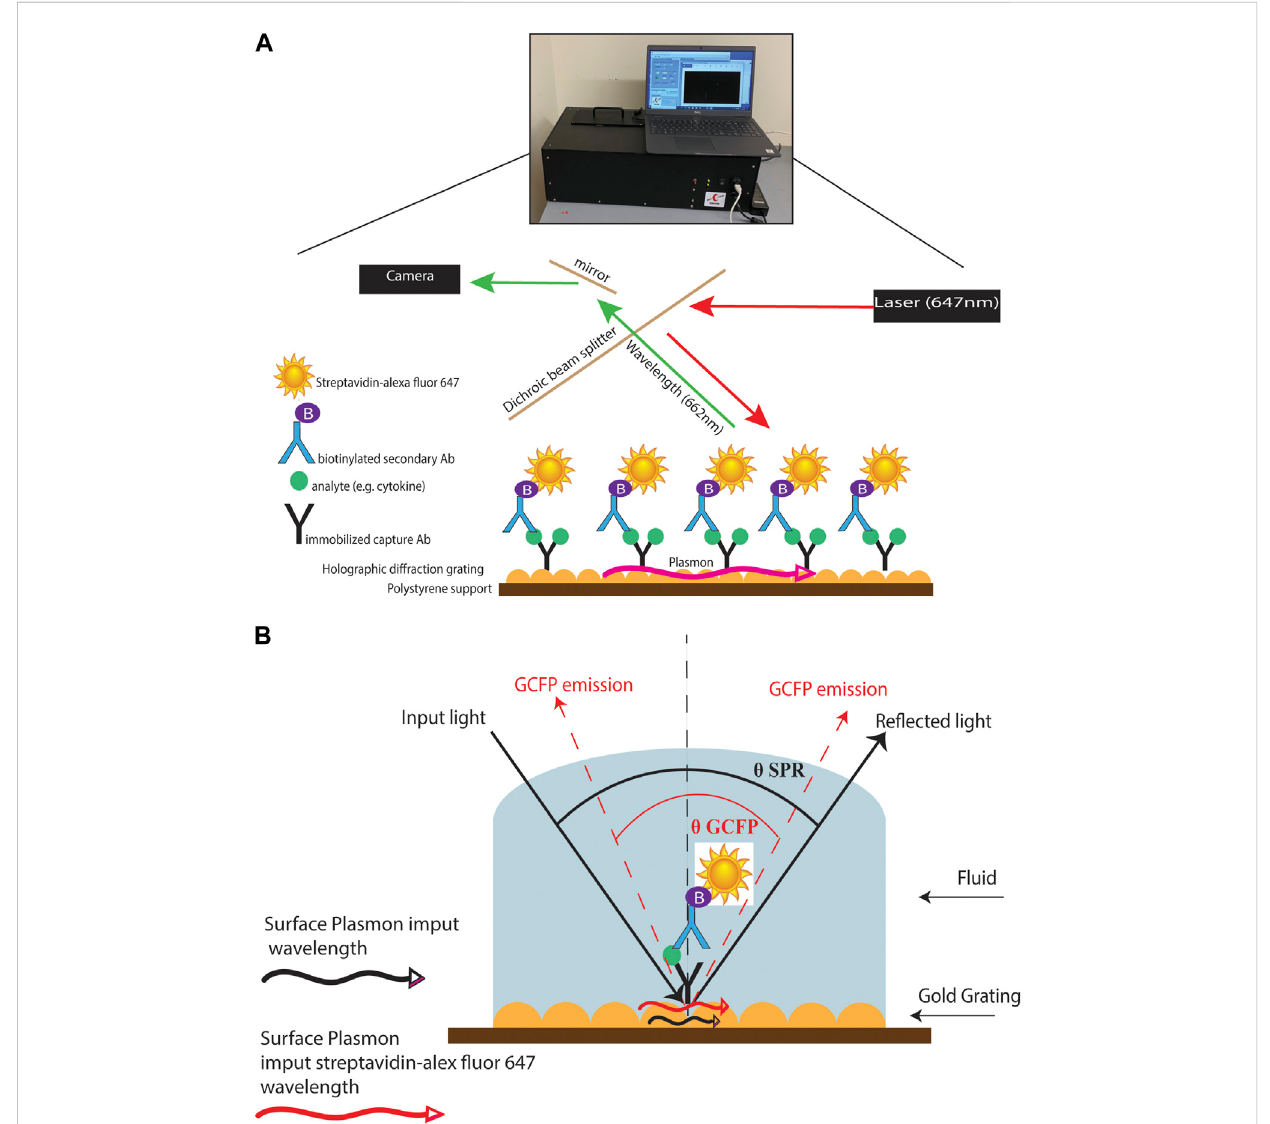
FIGURE 1 GCFP assay and wavelength pathway. ( A) Capture antibodies are immobilized onto a gold-coated nanoscale grating surface chip by pin spotting. Chips were then fi tted with plexiglass windows and gaskets to create a fl ow cell for fl uid to pass over the surface of the printed chip. Fluid containing potential analytes can then be run over the assembled chip, followed by biotinylated secondary antibodies and then streptavidin-Alexa fl uor647, with washesinbetweenstepswithPSB-T. ThechipcanthenbeplacedinaGCFPreaderwhere alaserilluminates thechipandthe fl uorescenceintensity is collected with a camera and each ROI is analyzed using Enhanced Fluorescence Reader software, V2.3. (B) . Under normal SPR optical conditions, the energy of the light excites electron density oscillation (the plasmon) within the metal coating on the sensor chip, reducing the intensity of the re fl ected light (Black lines). Using the diffraction grating on the chip, the wave vector of the illuminating beam of light can be matched with the plasmon wave vector (red lines). The gold grating plus the use of a fl uorophore increases the collected light, thereby enhancing the signal (red